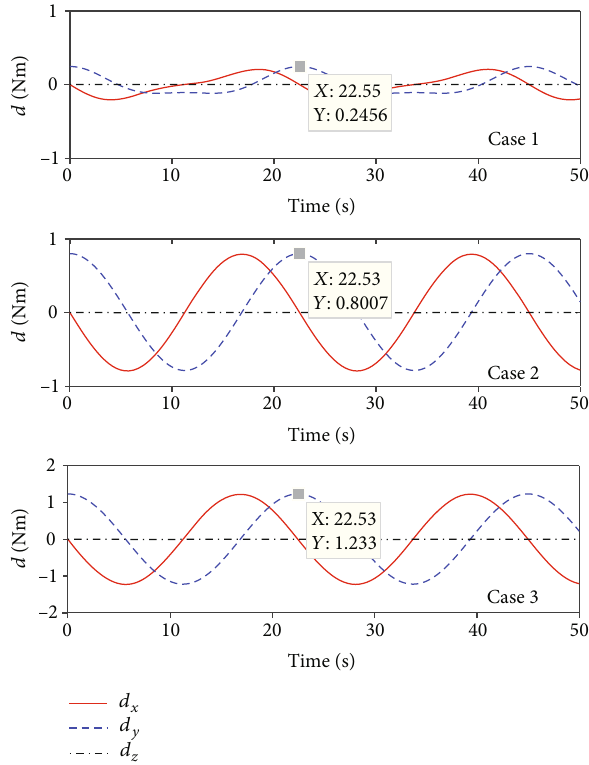
Figure 4: Theoretical results of the lumped